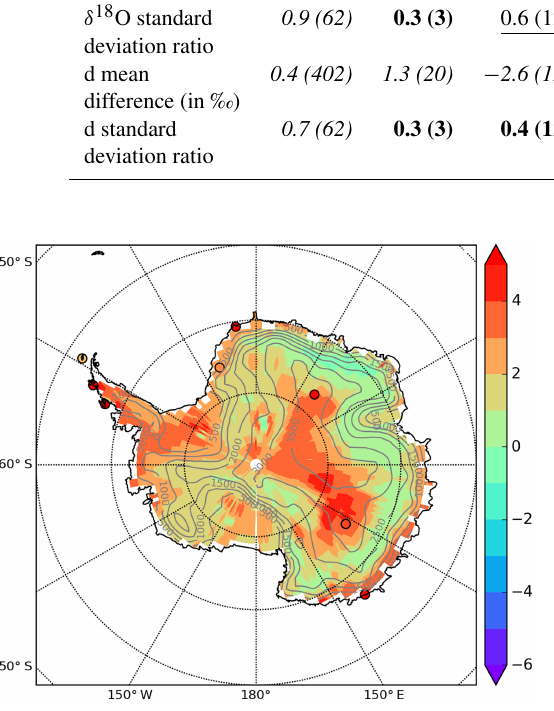
Figure 10. Best correlated phase lag between the mean seasonal cy- cle of deuterium excess and that of δ 18 O simulated by ECHAM5- wiso over the period 1979–2013 (colour shading) and calculated from precipitation data (circles). The sign provides information on the sign of the correlation between δ 18 O and d (e.g. positive num- bers correspond to a correlation, while negative numbers correspond to an anti-correlation). The absolute value corresponds to the lag (in months) between δ 18 O and deuterium excess corresponding to the highest correlation of monthly averaged values. This figure also dis- plays the Antarctic topography, with isohypses (in